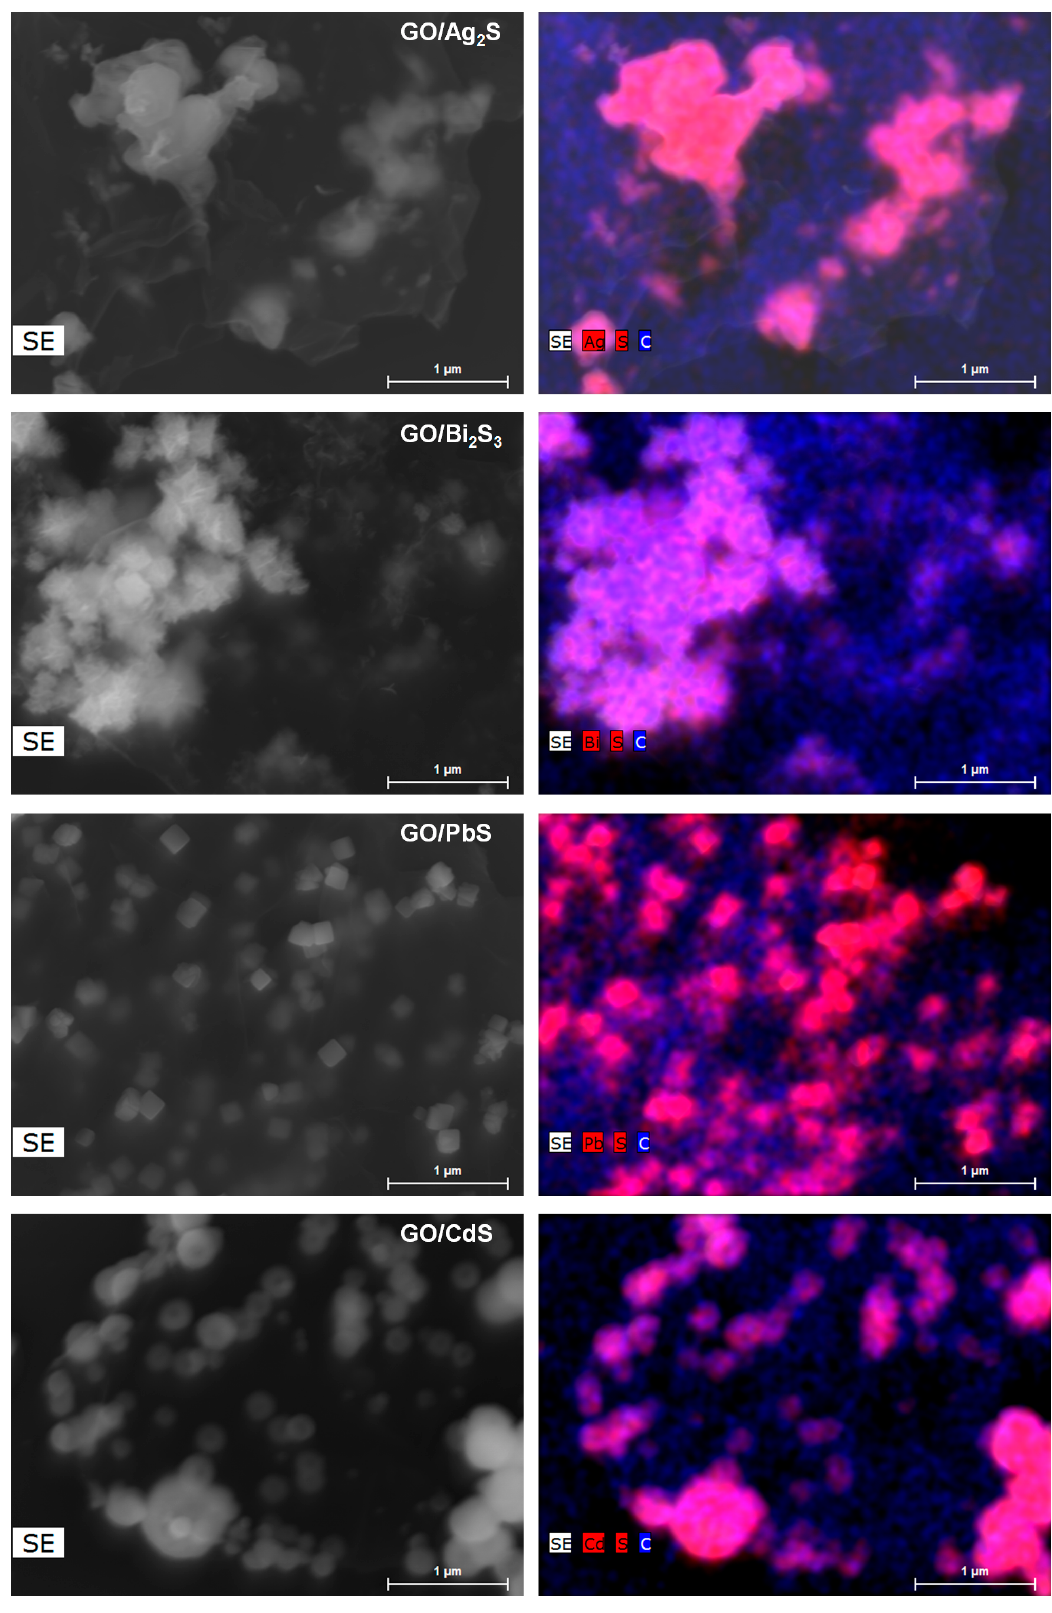
Figure 4. SEM images ( left panel) and EDX mappings ( right panel) of graphene oxide hybrid nanostructures containing metal sulfide nanophases.